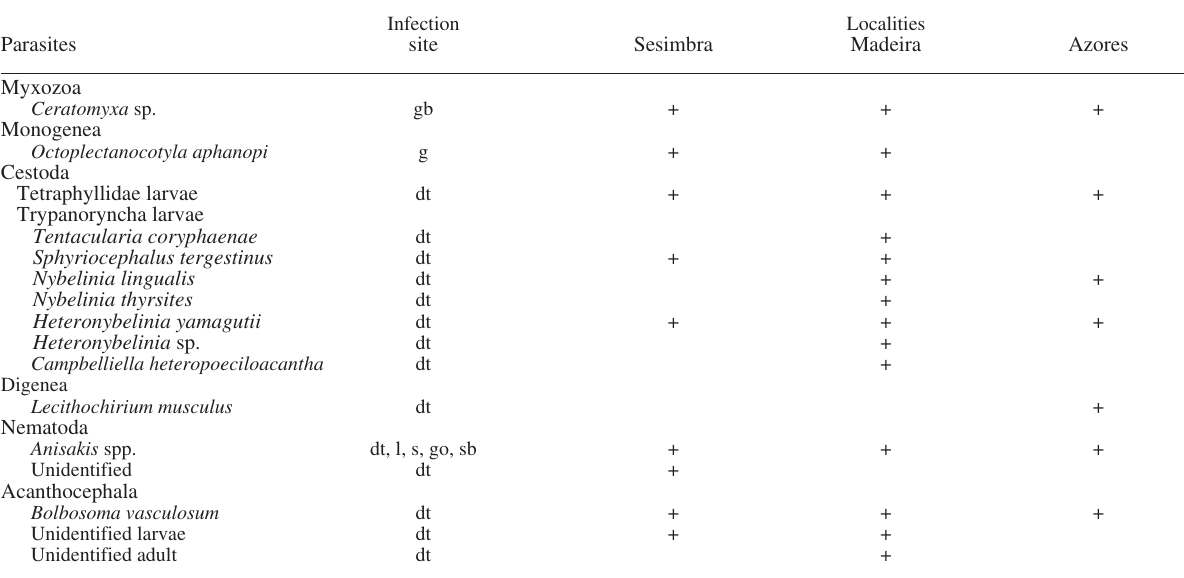
Table 3. – Parasites detected in Aphanopus carbo in the three sampling localities. abbreviations: +, present; dt, digestive tract; g, gills; gb, gall bladder; go, gonads; l, liver; s, spleen; sb, swimbladder.